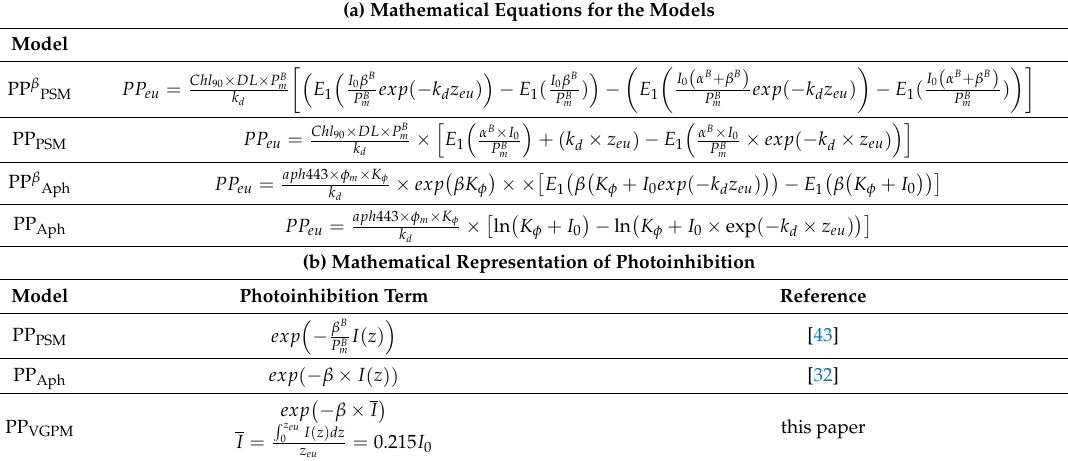
Table A1. Mathematical equations for PP PSM and PP Aph after integrating their P - I functions over the euphotic depth; (a) E 1 is an exponential integral defined as: E 1 ( x ) = representation of photoinhibition in the models